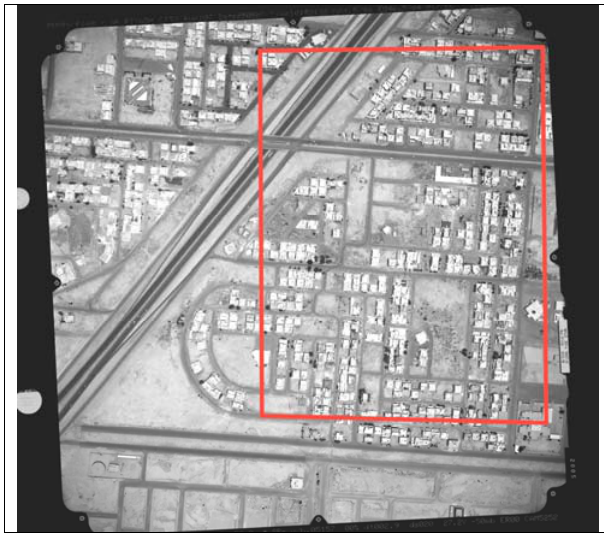
Figure 32: Area used for following building monitoring marked by red line